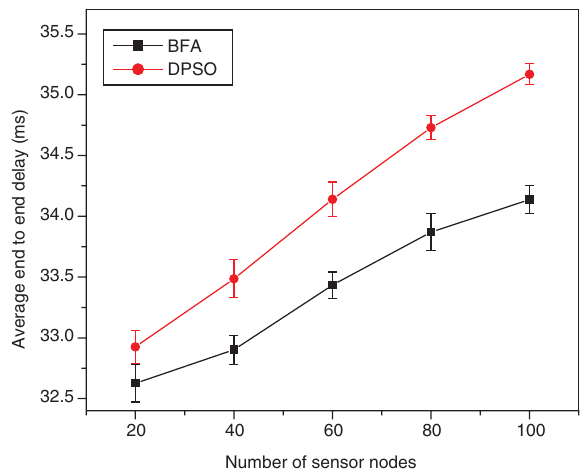
Figure 6: Sensor Nodes vs. Average End to End Delay.